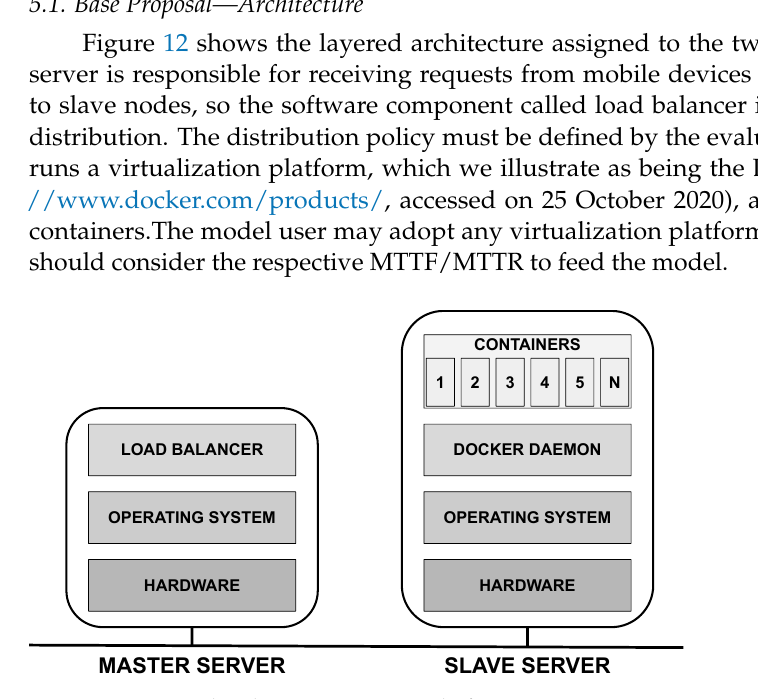
Figure 12. Layered architecture composed of two